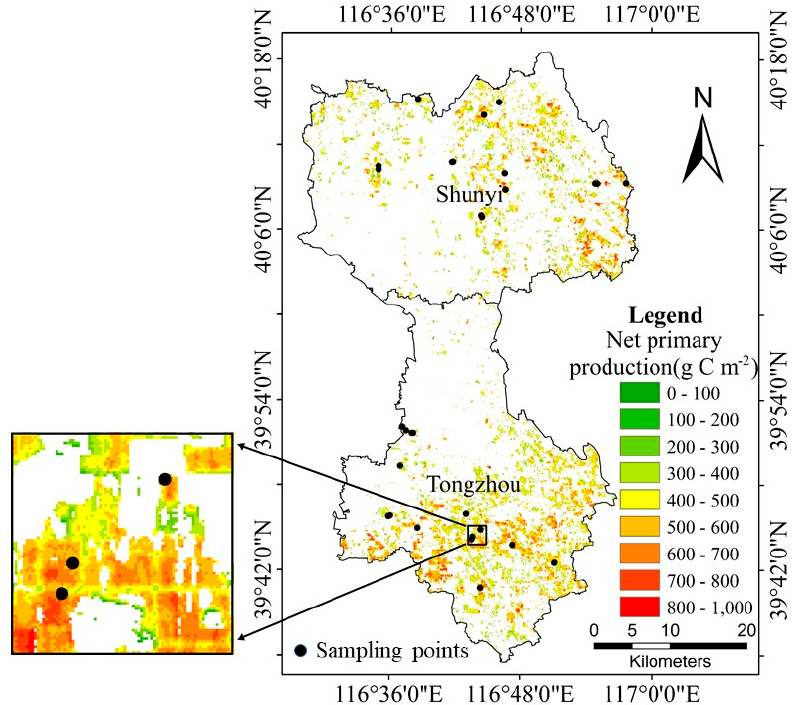
Figure 7. Spatial distribution of winter wheat NPP averaged for the 2008–2009 growing season.